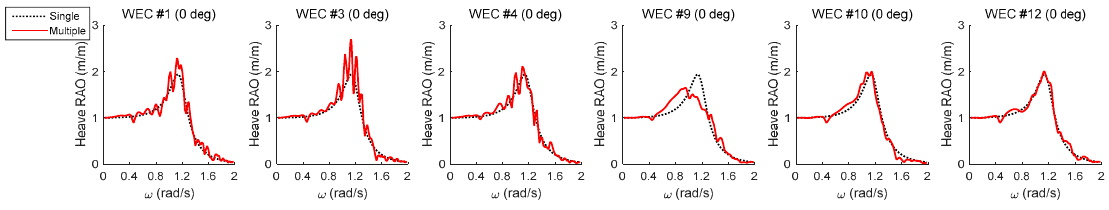
Figure 11. Heave RAO of WEC in array compared to heave RAO of the single WEC in the case of 0.0 deg wave-heading angle.